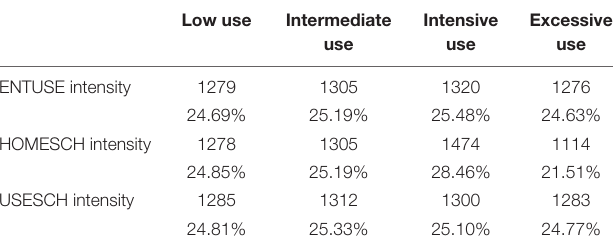
TABLE 3 | The distribution of ICT use intensity across three types of ICT